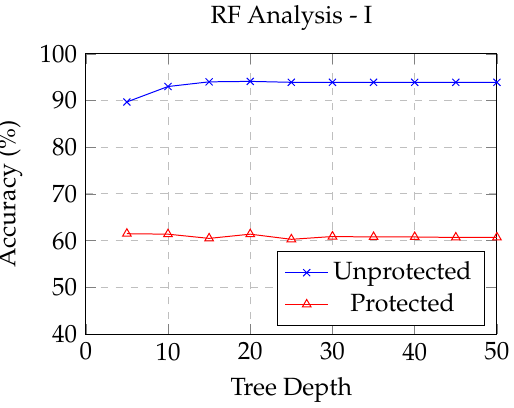
Figure 6. Analysis of Tree Depth values on accuracy for RF model.